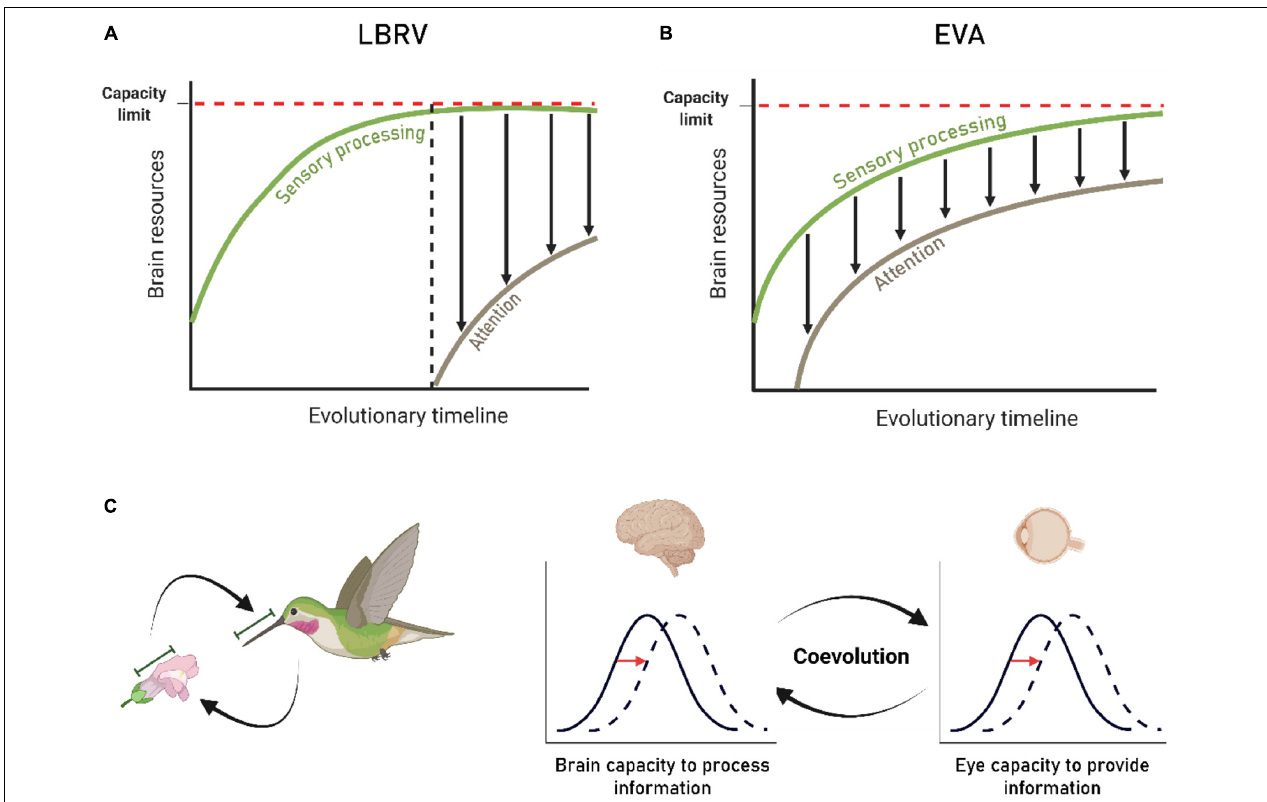
FIGURE 1 | Evolutionary considerations about stimulus selection and brain capacity. (A) Evolutionary timeline of attention under the traditional view [limited brain resources view of attention (LBRV)]. The green curve depicts resources required for the function of the brain. The competition over food resources drives an evolutionary increase in brain size and complexity, up to an upper physical limit (red dash line). At this point, attention emerges as a solution to the limited capacity problem (pink curve). However, selection and suppression (i.e., attention) consumes brain resources. This implies that attention has to come with a cost of less resources available for sensory processing (black arrows lengths). (B) Under the ecological view of attention (EVA) scheme stimulus selection and suppression of distractors (i.e., attention) is an important, indistinguishable part of sensory processing, both evolving together (pink and green curves). The EVA does not deny a limited capacity (red dash line). However, it asserts that attention evolved independent of the brain reaching its limited capacity. (C) The principle of coevolution is illustrated by the perfect match that can be found between the beak shapes of certain bird species and their host flowers. This principle, similarly predicts a match between the eye’s capacity to provide information and the brain’s capacity to make use of this information for adaptive behavioral control. The reciprocal arrows indicate the selective pressures within a coevolving system.